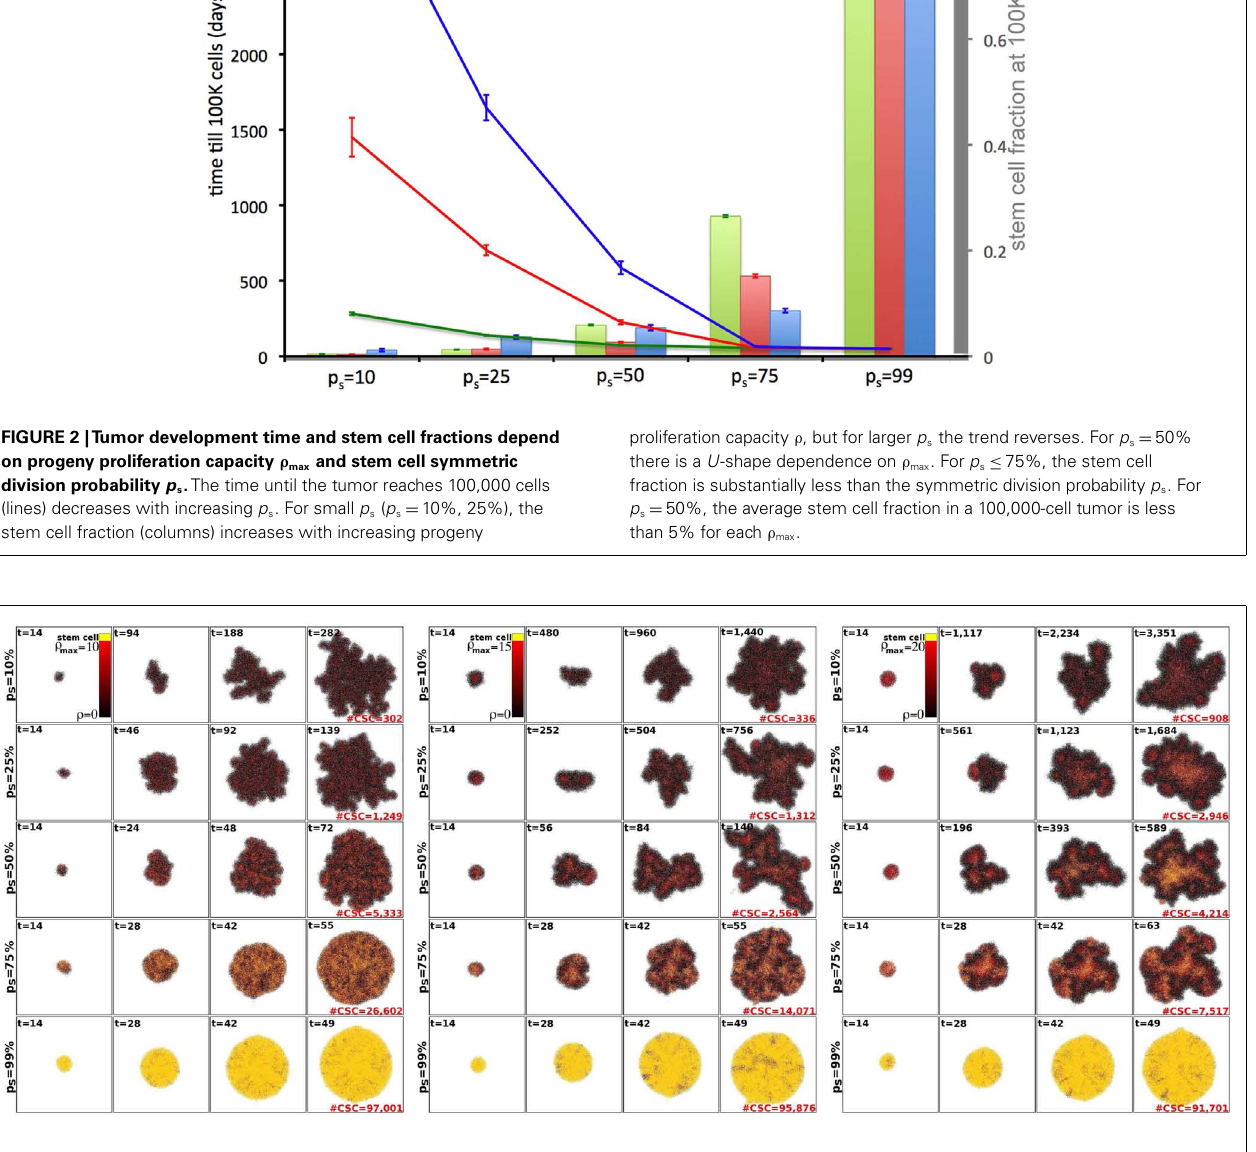
FIGURE 3 | Representative tumor morphologies for symmetric division probabilities p s = 10, 25, 50, 75, and 99% (rows), and for ρ max = 10, 15, and 20 (panels left to right). All tumors grown to 100,000